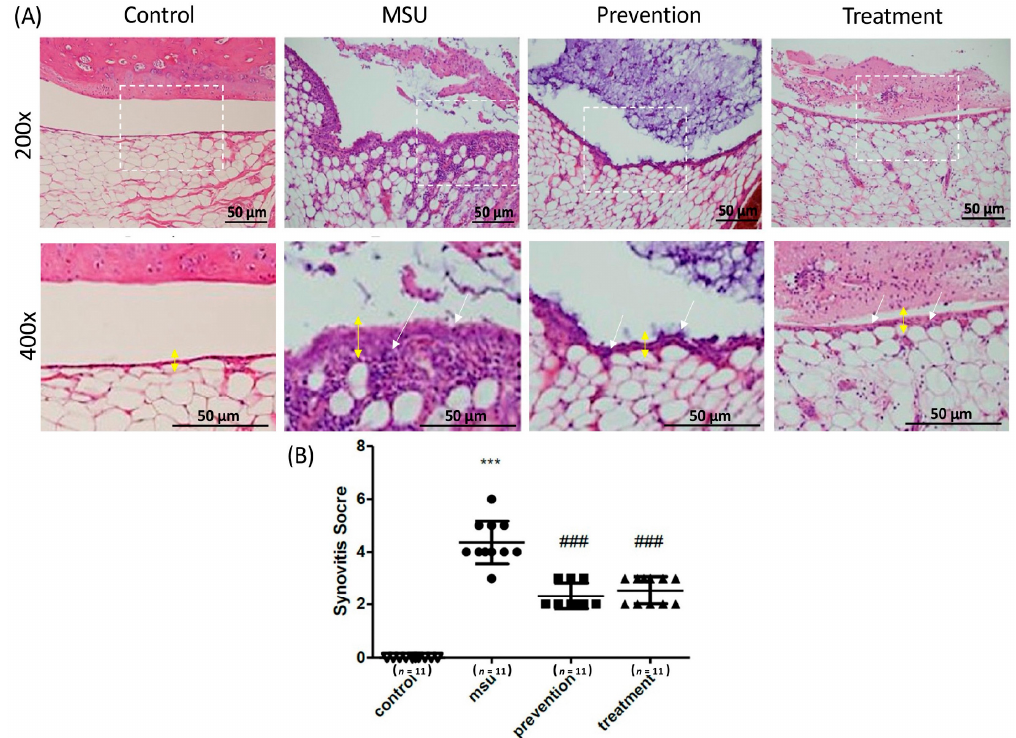
Figure 4. Histopathological analysis of rat knee joints in the four treatment groups, showing the effects of cardamonin on MSU crystals injected into the knee joint cavity: ( A ) Representative images showing H&E histological staining results (200× and 400×). Yellow double arrow: thickness of the synovial layer; white arrow: infiltration cells. Scale bars: 50 μ m. ( B ) Quantification of synovitis scores in the four groups including MSU, prevention, treatment, and control groups ( n = 11 in each group; *** p < 0.001 vs. control; ### p < 0.001 vs. MSU).